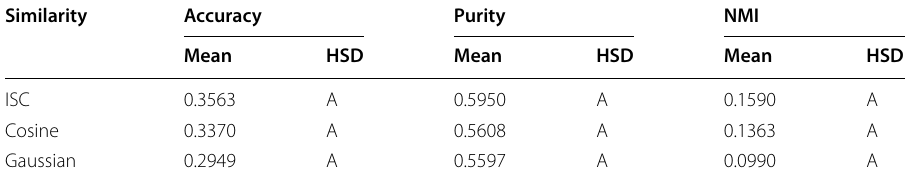
Table 7 Average performances of the similarity measure across all clustering learners and data sets